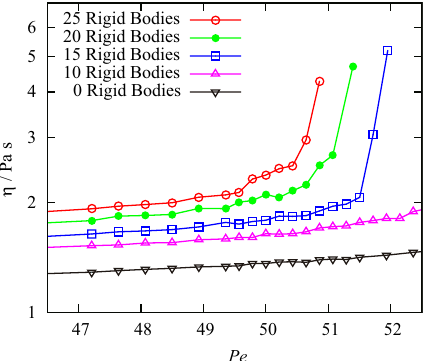
Figure 1. Rheology plot of the calculated systems composed of 0, 10, 15, 20, and 25 rigid bodies immersed in the